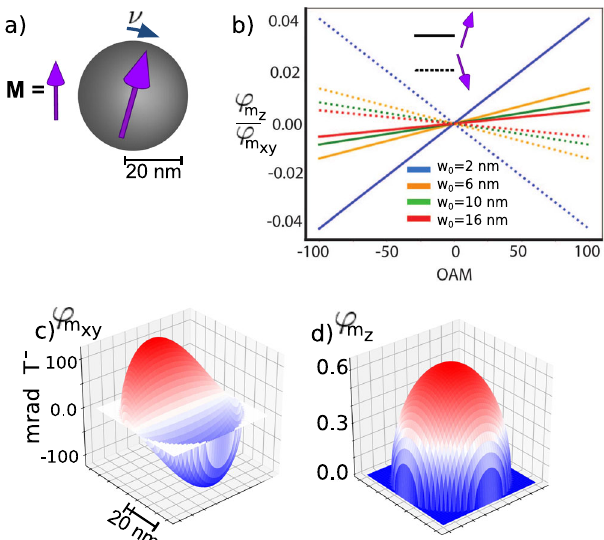
Fig. 1 The phase shifts from the in-plane and out-of-plane components of magnetization in a nanoparticle. a Schematic of a uniformly-magnetized nanoparticle, with M the magnetization and ν ¼ π is the angle the 6 magnetization is rotated away from the z -axis. The magnetic phase shifts due to the out-of-plane and in-plane components of magnetization are indicated by φ m and φ m , respectively. b Plot of the ratio of φ m to φ m z xy z xy imparted to the electron vortex beam (EVB) from a uniformly magnetized sphere rotated around the y -axis by π (solid lines) and 5 π (dashed lines). 6 6 Different quanta of orbital angular momentum (OAM) are shown along the horizontal axis. Colors correspond to EVB paths with beam waists of w 0 . Plots of φ m ( c ) and φ m ( d ), which are the phase shift due to in-plane and xy z out-of-plane magnetic induction, B xy and B z , respectively, in an EVB with OAM of 100. The phase shift per Tesla, mradT − 1 , is normalized to the magnetic induction in the nanoparticle; the colors correspond to the phase shift per Tesla shown along the y